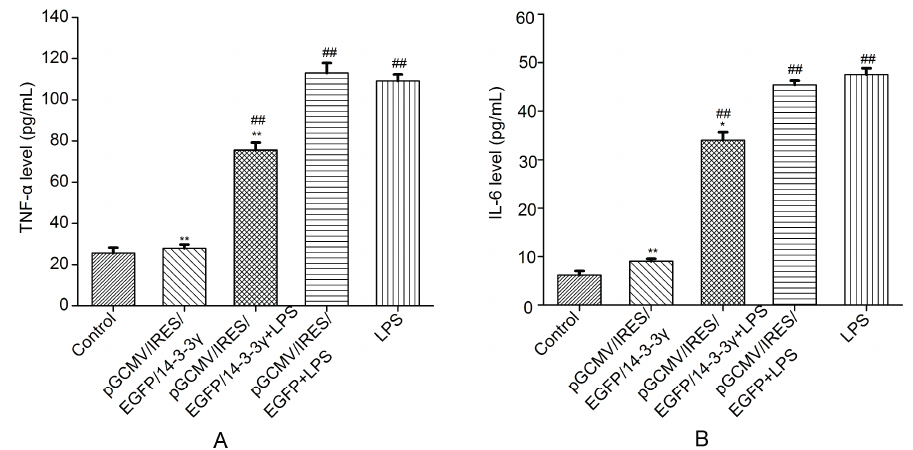
Figure 5. Effect of 14-3-3 γ overexpression on the production of inflammatory cytokines in LPS-induced DCMECs. DCMECs were pre-transfected with pGCMV-IRES-EGFP-14-3-3 γ or pGCMV-IRES-EGFP. After 24 h, the cells were stimulated with LPS (1 μ g/mL) for 6 h. The levels of TNF- α and IL-6 were detected by Enzyme-linked immunosorbent assay (ELISA). ( A ) TNF- α level; ( B ) IL-6 level. Bars indicate the mean ± SD ( n = 3). * p < 0.05 and ** p < 0.01 vs. LPS group; ## p < 0.01 vs. control group. 2.6. 14-3-3 γ Overexpression Inhibited the Mitogen-Activated Protein Kinase (MAPK) Signal Pathway in LPS-Induced DCMECs